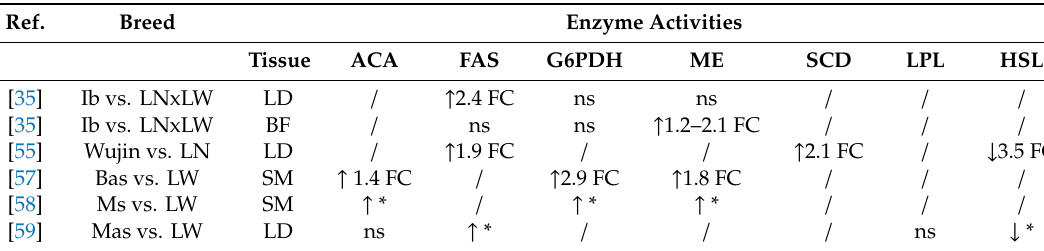
Table 3. Lipogenic enzyme activities in intramuscular fat for di ff erent muscles in local pig breeds compared to modern pig